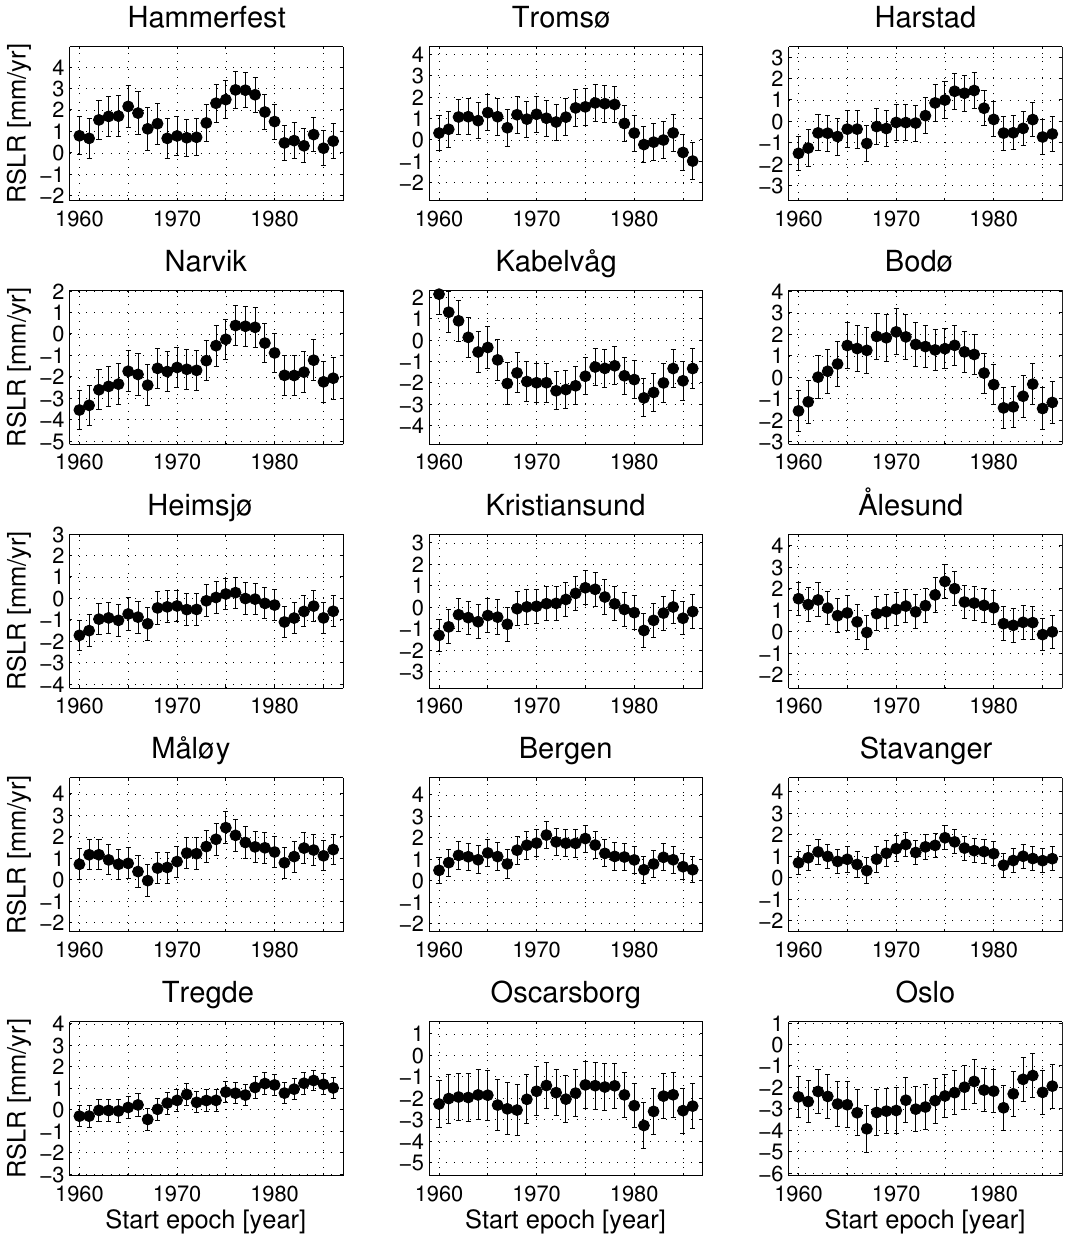
Figure 4. Relative sea-level rates from some tide-gauge records, computed for 30-year moving windows shifted in steps of 1 year as a function of the starting year of the 30-year period. The error bars indicate one standard